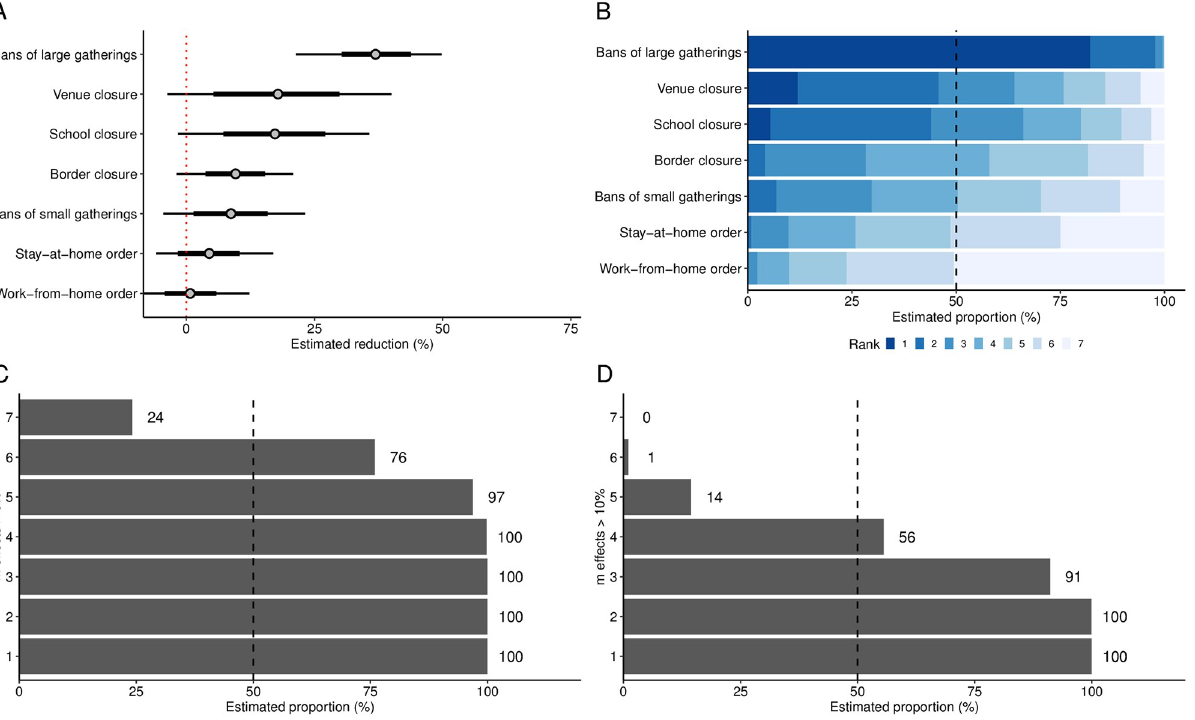
PLOS ONE | https://doi.org/10.1371/journal.pone.0252827 June 2,